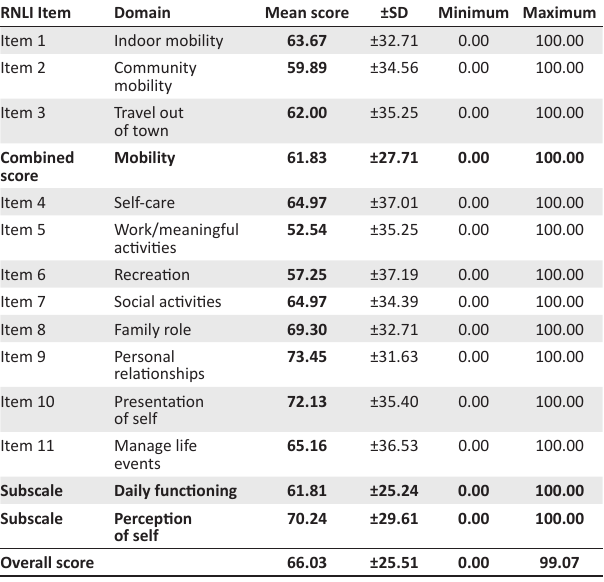
TABLE 2: Descriptive statistics of the Reintegration to Normal Living Index scores (RNLI) ( n = 59). RNLI